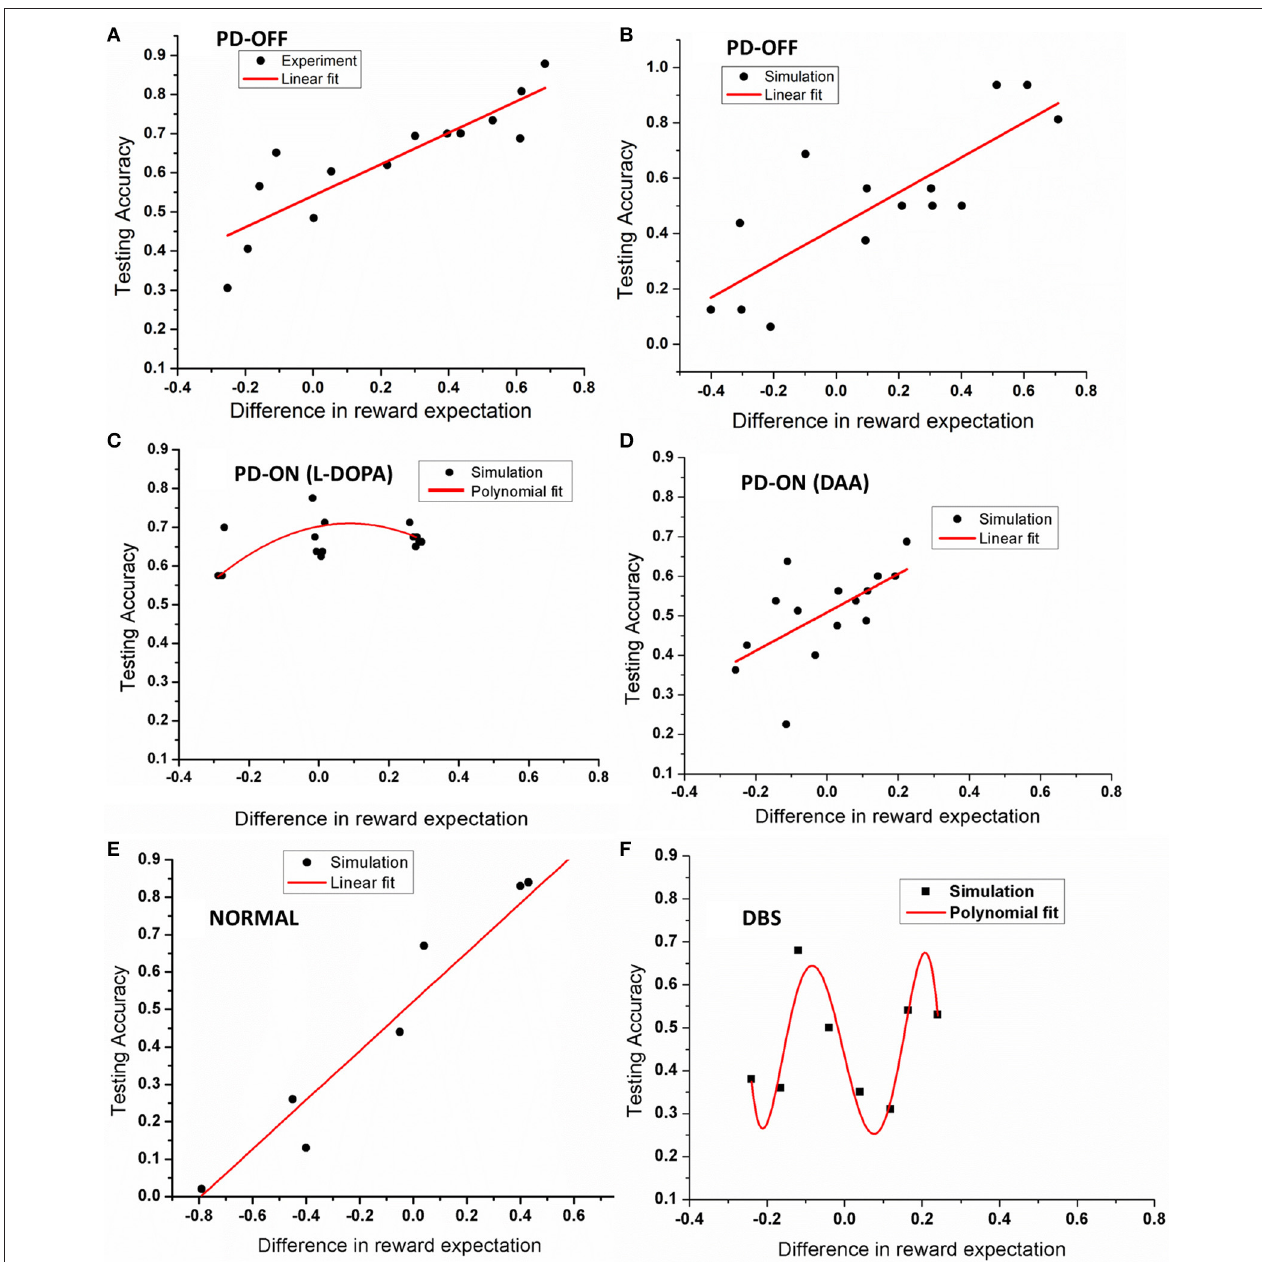
FIGURE 4 | Shows an example plot of testing accuracy against DRE for (A) PD OFF experiment, (B) PD OFF simulation, (C) PD ON (L-DOPA), (D) PD ON (DAA), (E) Normal, and (F) DBS conditions. X-axis shows difference in reward expectation (DRE) and Y-axis indicates the performance during testing.